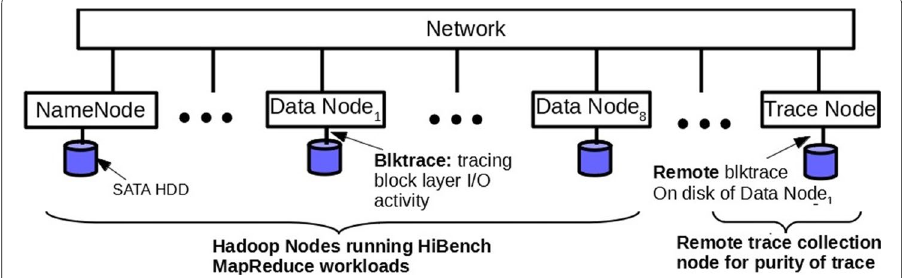
Fig. 10 Experimental testbed: Hadoop cluster and capturing block layer I/O activity using blktrace